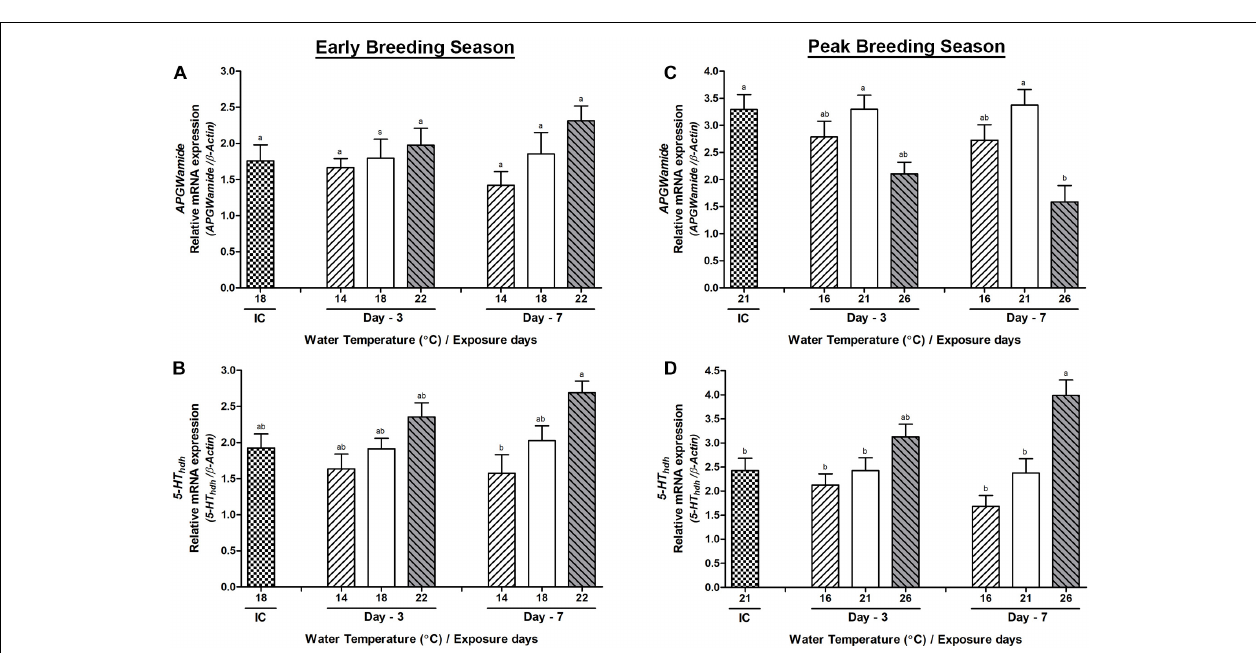
FIGURE 7 | Changes in the relative mRNA expression of 5-HT hdh (A,B) in the cerebral ganglion (CG) of male Pacific abalone during early and peak breeding seasons after exposure to thermal stress for 7 days. Before exposure to the target temperature of thermal stress, abalone were sampled to obtain reference values that served as initial control (IC). Values represent the mean ± SD ( n = 10). Different letters on the bar indicate significant differences among different temperature groups ( p < 0.05).